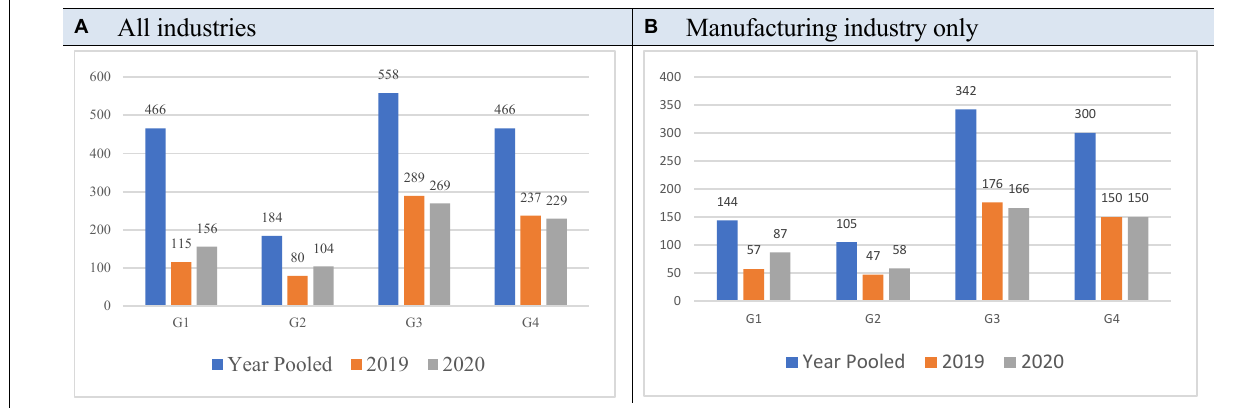
Additionally, the chi-square test and the difference test of population ratio are performed for the years 2019 and 2020